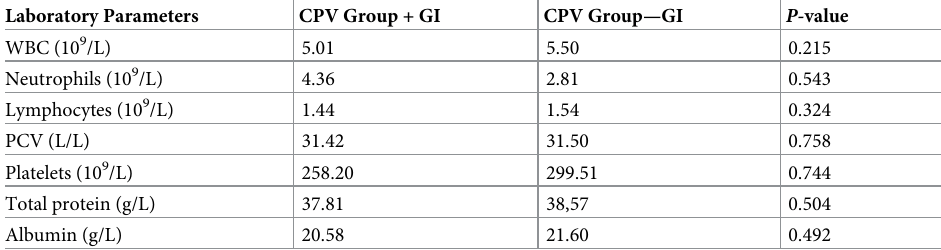
Table 2. Comparison of laboratory